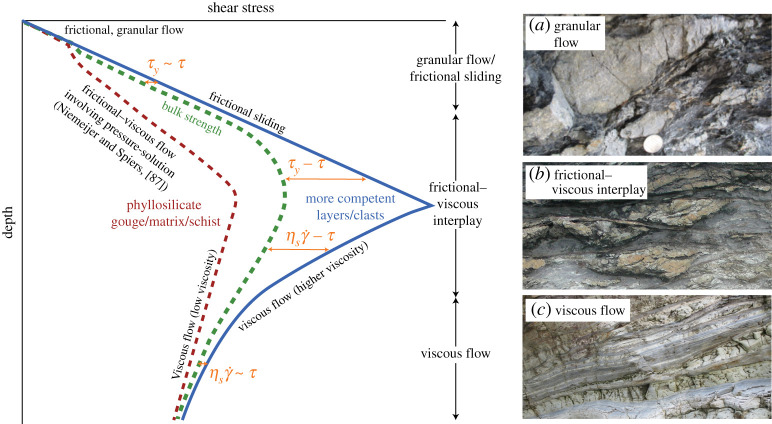
Schematic diagram showing the difference in depth-dependent strength between two components. The red, dashed curve shows a relatively weak, fine-grained phyllosilicate-rich matrix deforming preferentially by pressure solution creep. The blue, solid line represents coarser-grained layers, possibly dismembered into oblate clasts, that are too coarse for efficient pressure solution. The stress driving bulk deformation (intermediate, dashed green curve) is expected to be similar to the frictional yield strength (τ ∼ τy) in the frictional regime, and similar to the viscous strength of competent material at the imposed strain rate (τ∼ηsγ˙) in the viscous regime. Deviations from these conditions are associated with the frictional–viscous interplay zone. Photographs to the right show potential structures developing in this material mixture: (a) sandy layers dismembered by granular flow in a mudstone matrix (Makimine Mélange, Japan), (b) dismembered sand and chert layers in a cleaved, phyllosilicate rich matrix, cross-cut by anastomosing faults (Chrystalls Beach Complex, New Zealand), (c) layers of sheared metapelite, metapsammite, and metabasalt, with near-planar margins indicating small viscosity contrast (Makimine Mélange, Japan).(Online version in colour.)